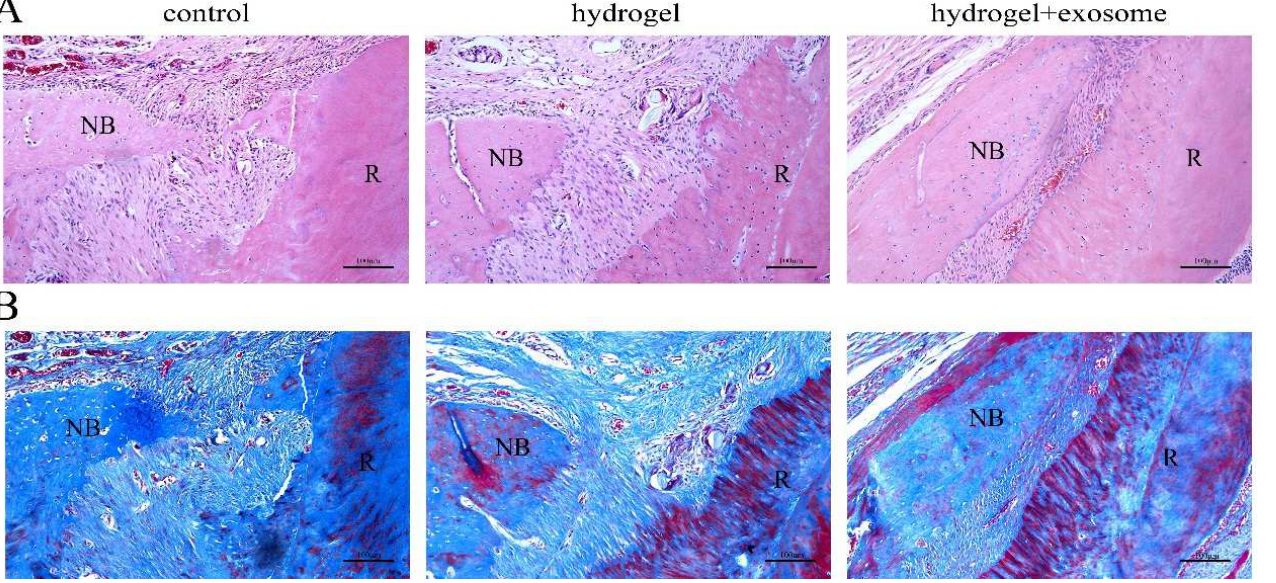
Figure 6. Histological evaluations of bone formation at 4 weeks post-surgery ( A ) HE staining images of alveolar bone in control, hydrogel and hydrogel+exosome groups, respectively. Compared with the control and hydrogel groups, the hydrogel+exosome group had more new bone deposition. ( B ) Masson staining images of alveolar bone in control, hydrogel and hydrogel+exosome groups, respectively. Compared with the control and hydrogel groups, the hydrogel+exosome group had more new bone deposition. R: root; NB: new bone of periodontal regeneration.